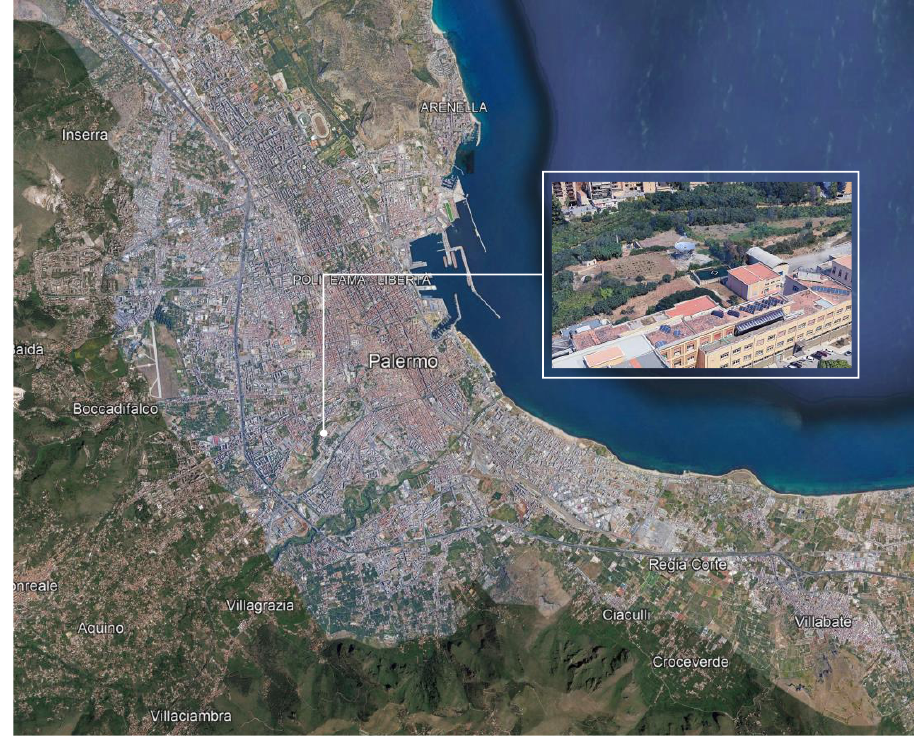
Figure 3. The location of the reference dish – Stirling system (Palermo, Italy).